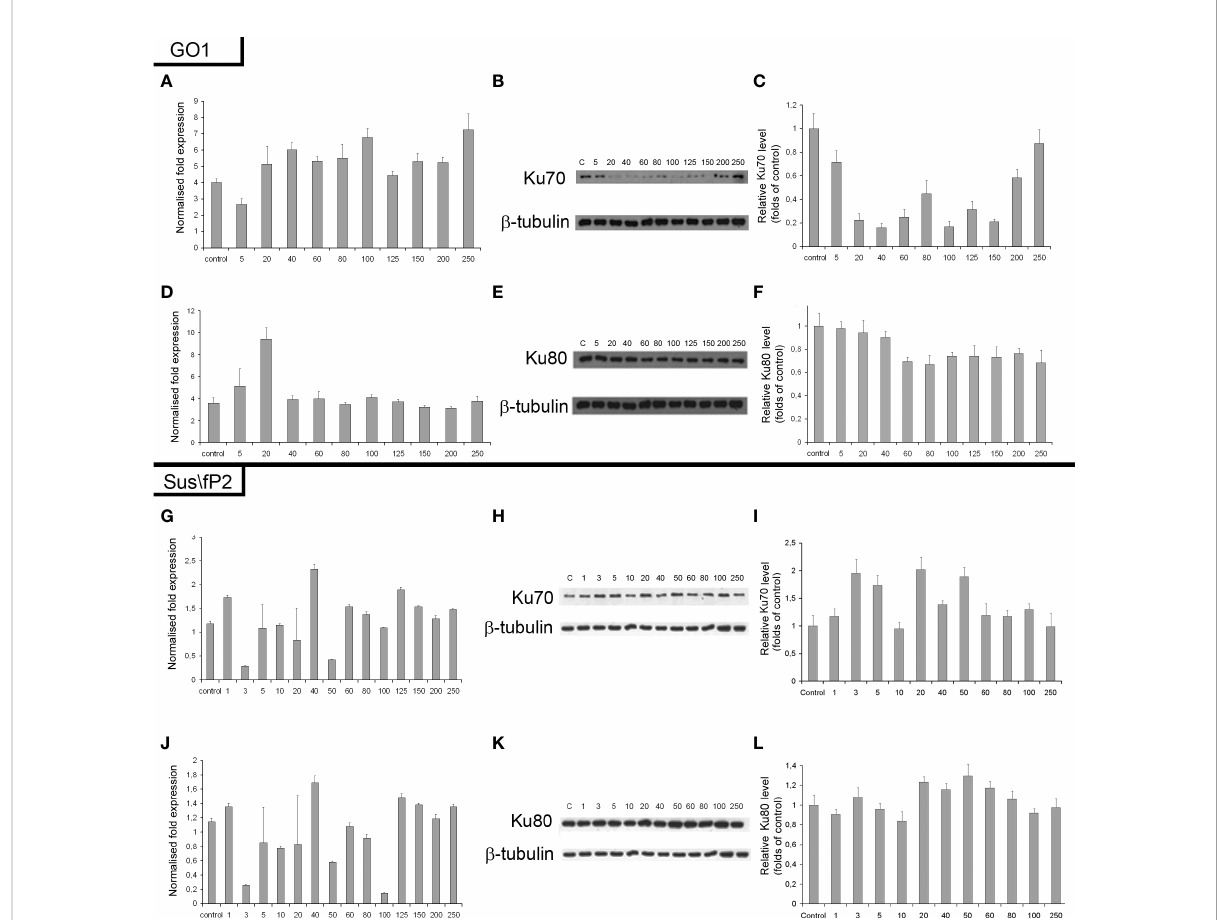
FIGURE 8 Expression of XRCC6 gene (A) and its product Ku70 (B, C) as a function of radiation dose in glioblastoma GO1 cell culture. Expression of XRCC5 gene (D) and its product Ku80 (E, F) as a function of radiation dose in GO1 cell culture. Expression of XRCC6 gene (G) and its product Ku70 (H, I) as a function of a single radiation dose from 5 to 250 G g in glioblastoma Sus\fP2 cell culture. Expression of XRCC5 gene (J) and its product Ku80 (K, L) as a function of a single radiation dose from 5 to 250 G g in Sus/fP2